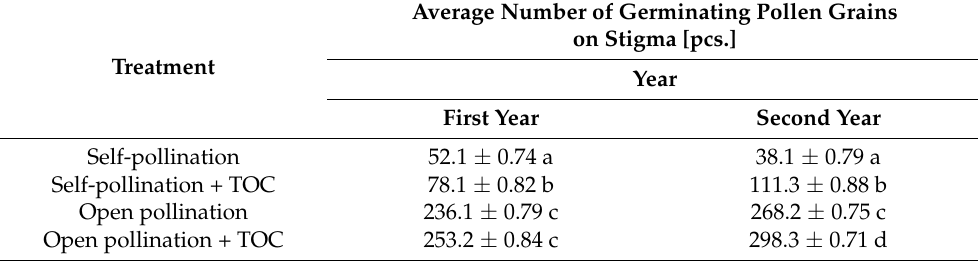
Table 1. The effect of experimental factors: type of pollination and application of titanium organic complex (TOC) on the germination of pollen grains on the